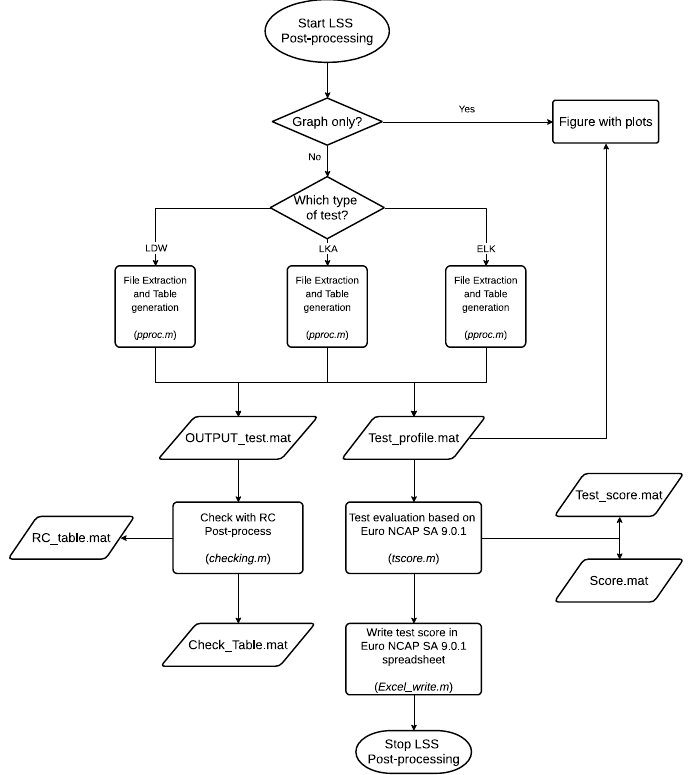
Figure 14. Flowchart of the main code for LSS tests.